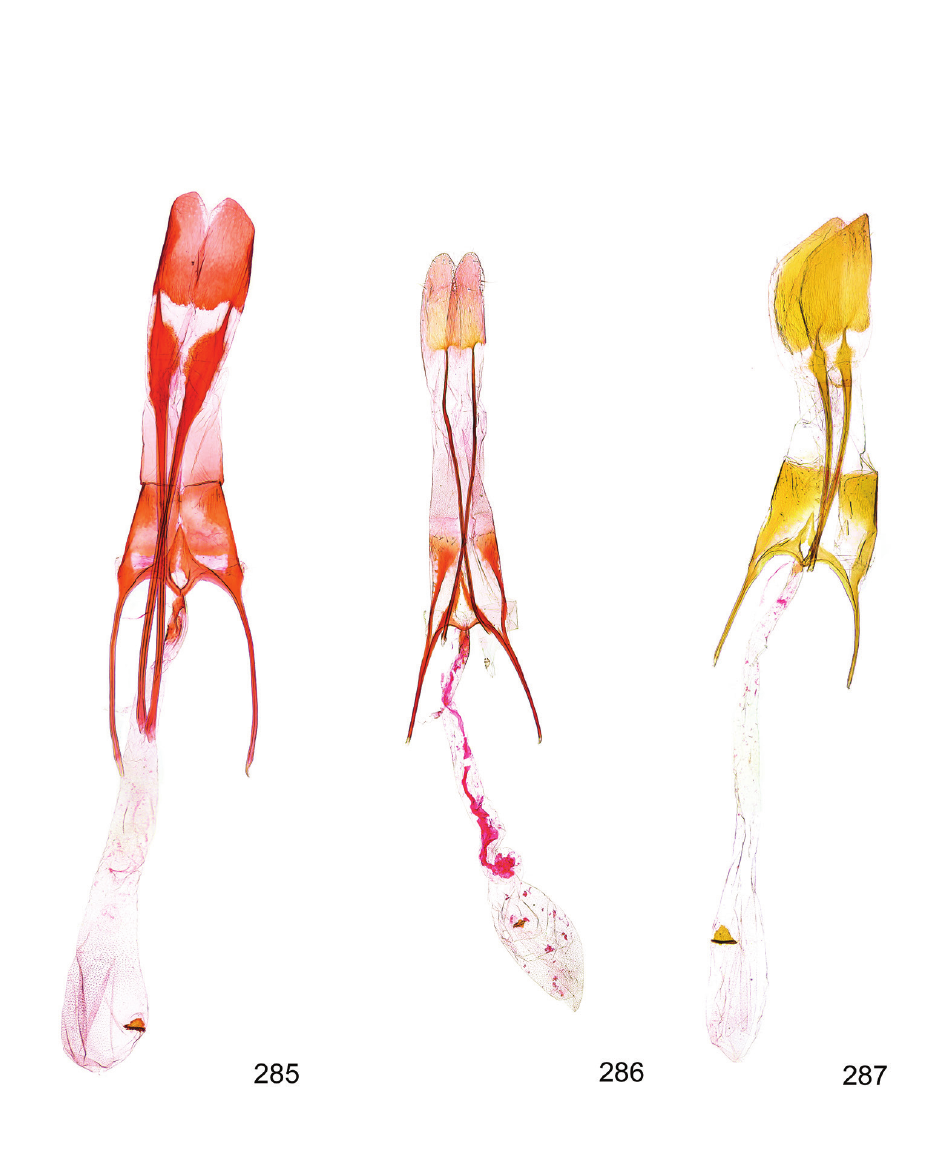
Figures 285–287. Megacraspedus female genitalia. 285 M. niphorrhoa (Meyrick, 1926) – Russia, GU 17/1493 P.H. (RCKN) 286 M. albella (Amsel, 1935) – Paratype, Iran, gen. slide 16.664 (NHMW) 287 M. balneariellus (Chrétien, 1907) – Italy, GU 17/1476 P.H.